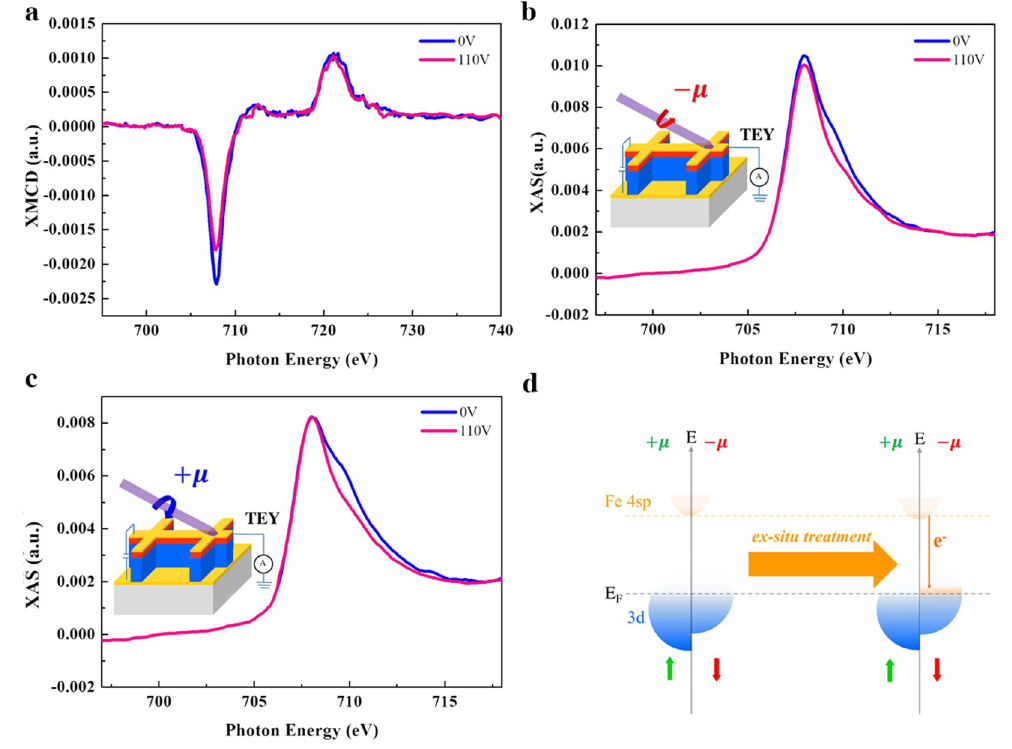
Figure 4. Helicity/spin-resolved x-ray results. ( a ) Fe L 2 / L 3 XMCD spectra with and without 110 V- ex-situ treatment . ( b ) Helicity-dependent ( μ ( + ) and μ ( − )) Fe L 3 XAS spectra with and without 110 V- ex-situ treatment . Inset of ( b ) illustrates the x-ray measurements with two x-ray helicities. ( d ) Illustration for the spin-dependent electronic diagram of the Fe layer in relation to the charge transfer effect upon ex-situ treatment . μ ( + ) and μ ( − ) correspond to the different x-ray helicities associated with majority and minority state, respectively. The charge transfer only involves the change in Fe’s minority